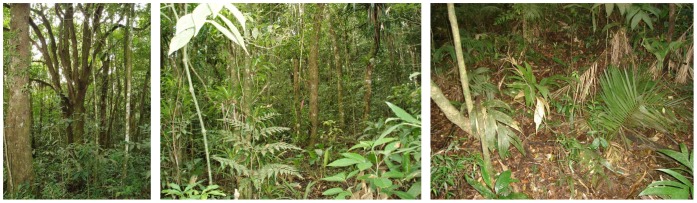
Photographs showing the typical structure of the (a) forest, (b) understory and (c) litter layer within the study area.